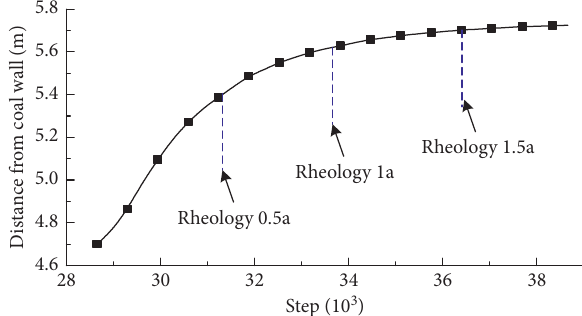
Figure 14: Support pressure peak evolution